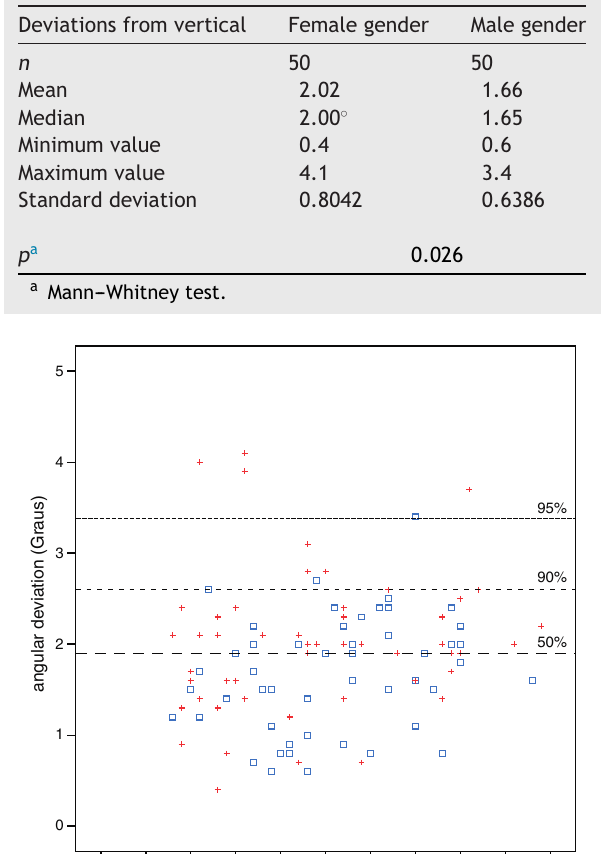
Measurements --- summary of absolute values of deviations from the vertical, according to gender and statis- tical comparison.